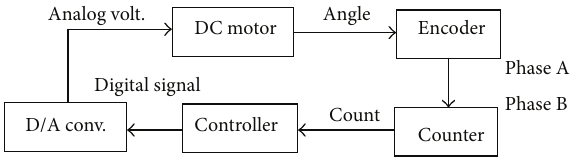
Figure 5: The motor control